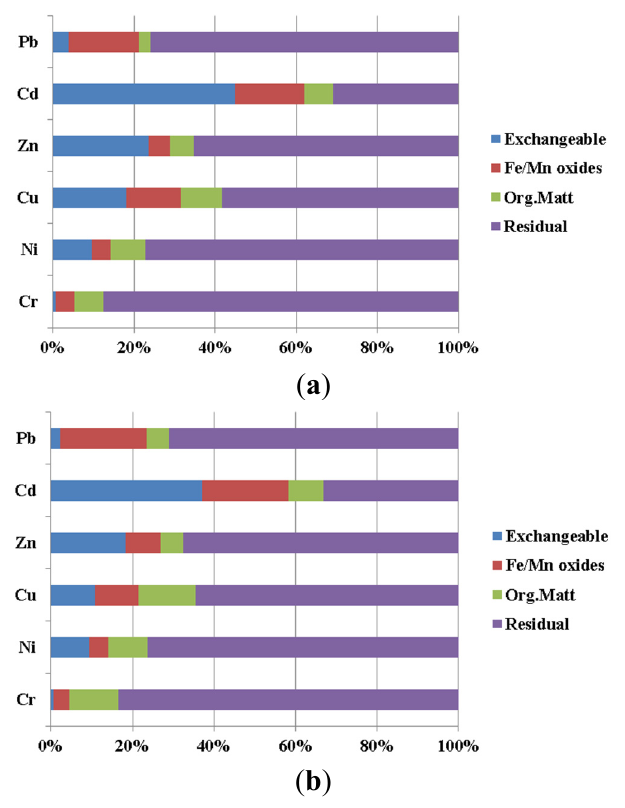
Figure 2. Partitioning of metals in the sediments. ( a ) Downstream; ( b )